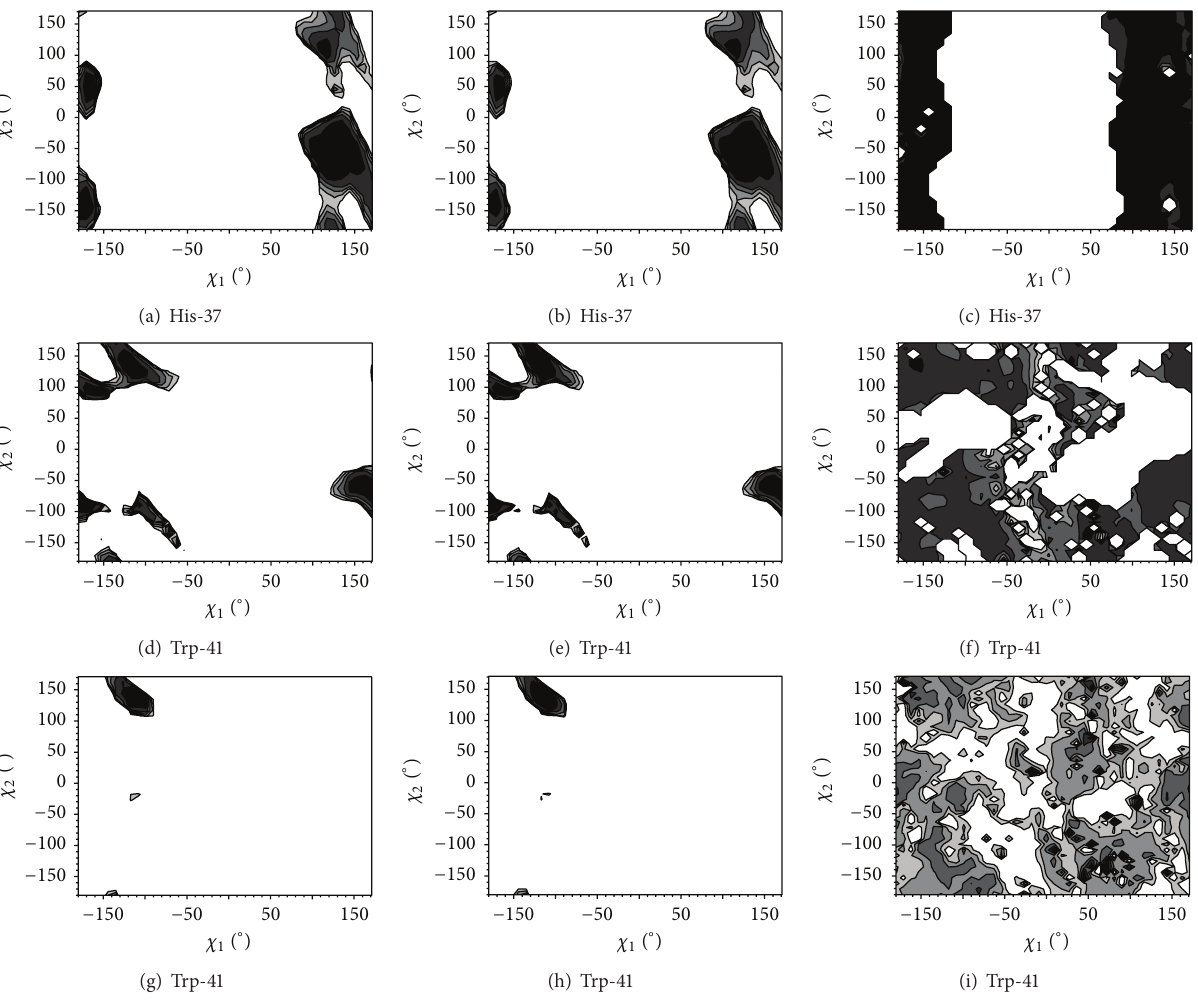
Figure 7: Torsion angle: energy maps of His-37 with fixed Trp-41 at ( 𝜒 1 , 𝜒 2 ) = ( − 100 ∘ , +110 ∘ ) in (a), (b), and (c) and maps of Trp-41 with fixed His-37 at ( 𝜒 1 , 𝜒 2 ) = (+120 ∘ , +110 ∘ ) in (d), (e), and (f) and ( − 180 ∘ , − 180 ∘ ) in (g), (h), and (i) for pH 8.0/closed state. Panels (a), (d), and (g) represent total energies, (b), (e), and (h) Van der Waals energies, and (c), (f), and (i) electrostatic energies. All energy maps are shown within a 5MJ/mol range from minimum (black) to higher energies (dark grey, grey, light grey, and